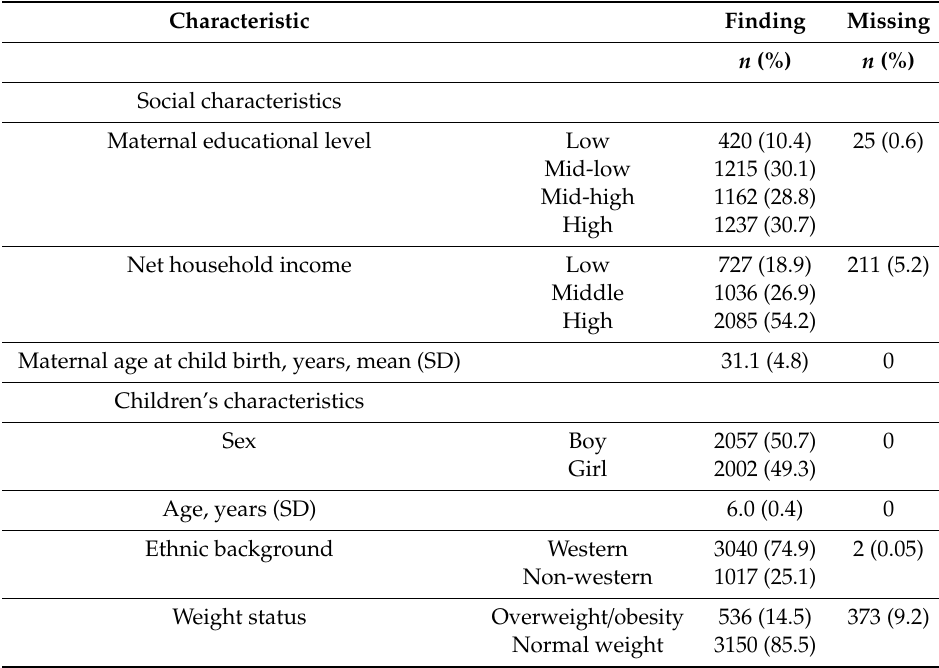
Table 1. Characteristics of children and their mothers ( n =